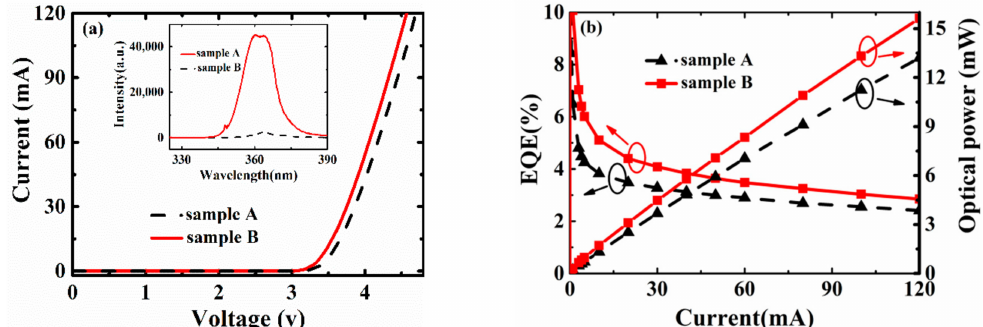
Figure 6. ( a ) The measured I–V characteristics of both samples (the inset shows the PL (Photoluminescence) spectrum at room temperature); ( b ) the optical output power and external quantum e ffi ciency of both